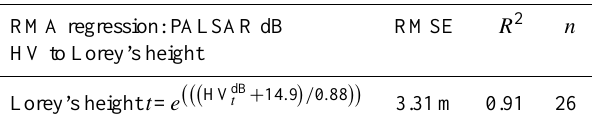
Table 1. Regression equation for relationship between 2007 HV backscatter and the binned Lorey’s height data taken from the ICE- Sat data